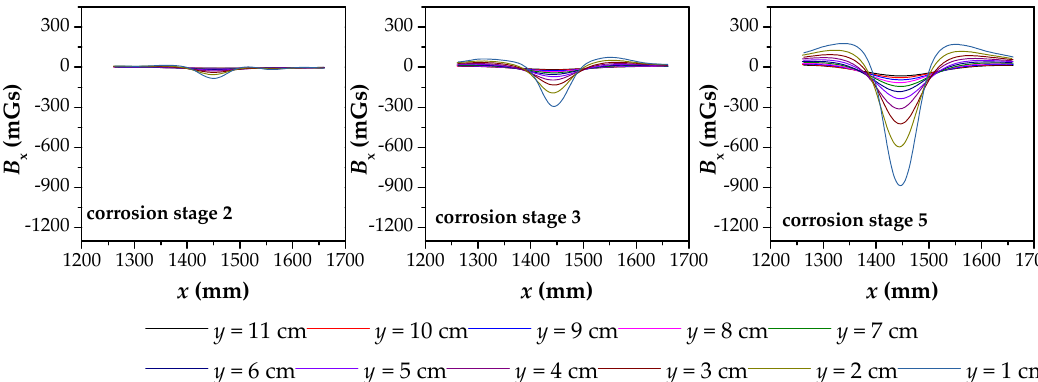
Figure A3. The B x curves of S1 under residual corrosion stages. S1: the steel strand; B x : the magnetic flux component of x direction; x : the coordinate along the length of the specimens. Table A1. The calculation sheet of error.